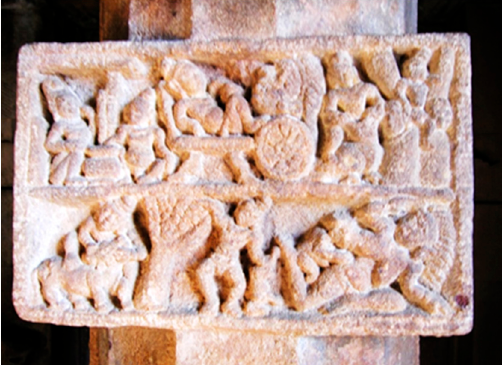
Figure 9. Exploits of the Young K ṛṣṇ a (left to right): Arrival of K ṛṣṇ a at the Cowherd Village, Churning without “Butter-thief,” Slaying of P ū tan ā , Arjuna Trees Episode, sixth–seventh century. Carving from B ā d ā m ī Fort, possibly transferred from the Upper Sivalaya Temple, B ā d ā m ī , Karnataka. B ā d ā m ī Museum.